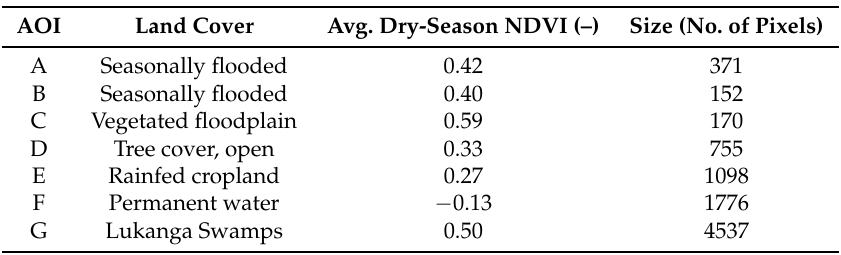
Table 1. Characteristics of selected